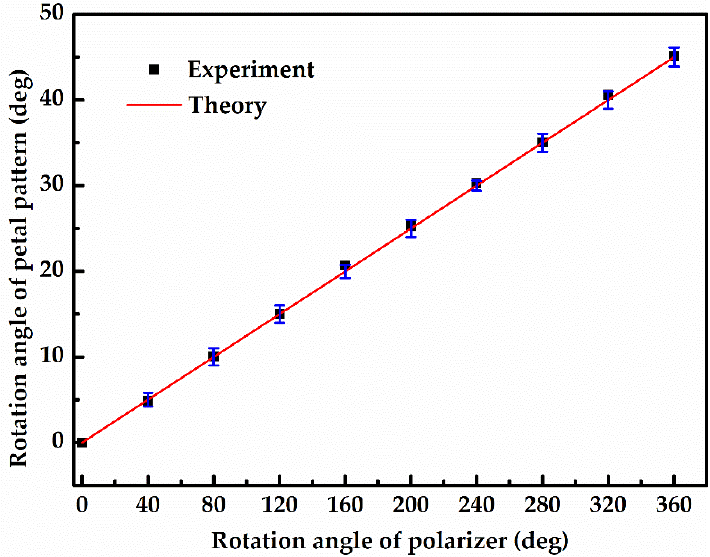
Figure 7. Validity test with rotating polarizer.